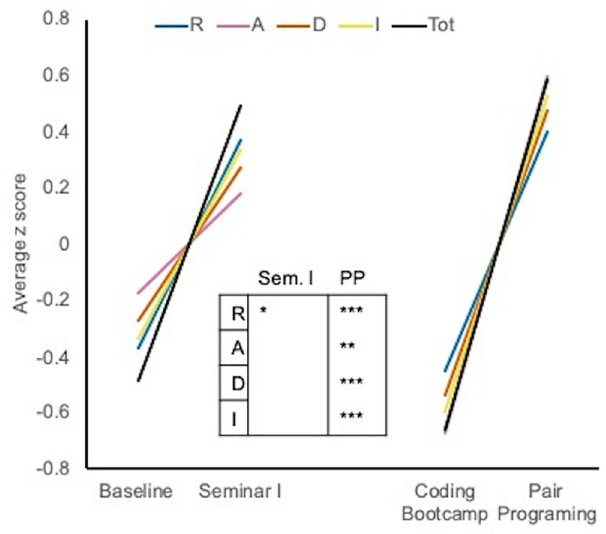
Fig 3. Average z-scores of total CT score at the indicated DIVAS pipeline interventions. A paired t-test was used to compare means before and after Seminar I. A two-sample t-test was used to compare means before and after pair programming (PP). � , p < 0.05; �� , p < 0.01; ��� , p <